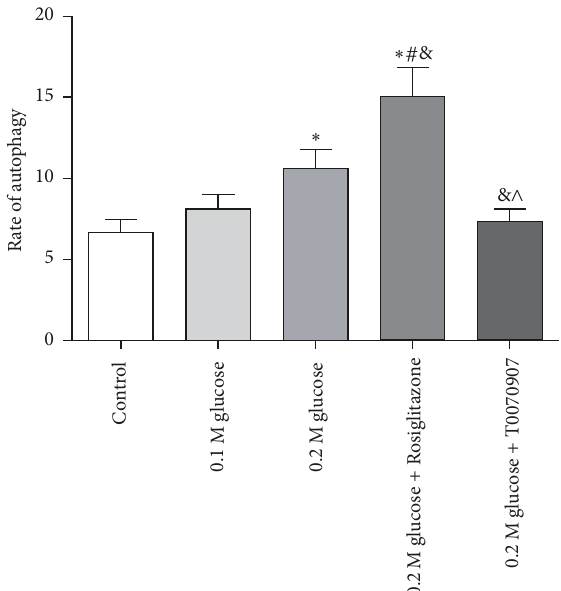
Figure 7: The rate of autophagy under different medium conditions was shown and the PPAR 𝛾 activation could induce autophagy significantly. ∗ representsasignificantdifferencefromthecontrolgroup;#representsasignificantdifferencefromthe0.1 Mglucosecondition; & represents a significant difference from 0.2 M glucose condition; and ∧ represents a significant difference from 0.2 M high glucose condition plus agonist (𝑝 < .05)